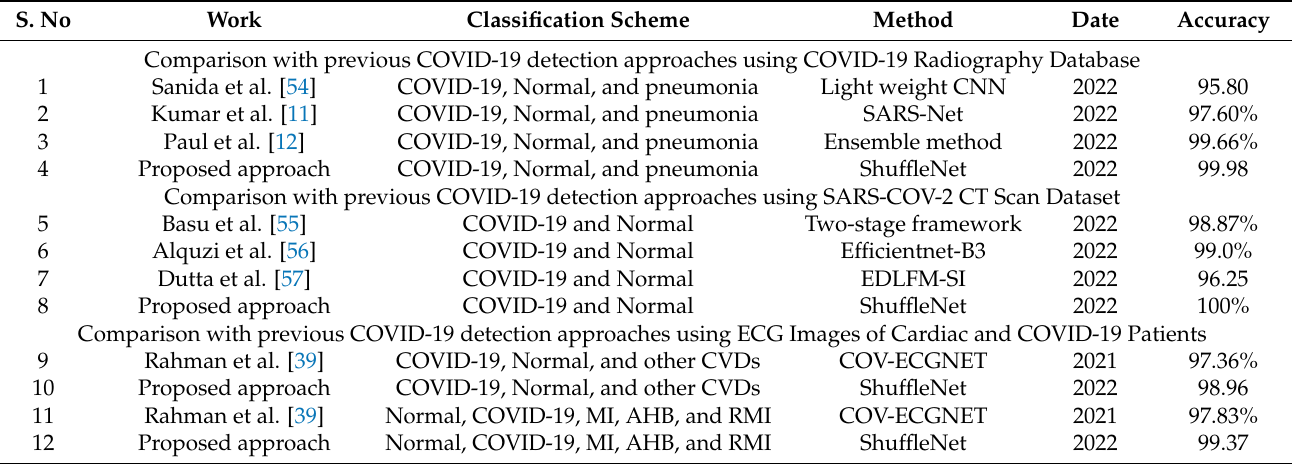
Table 16. Accuracy comparison with state-of-the-art models in the literature. S.